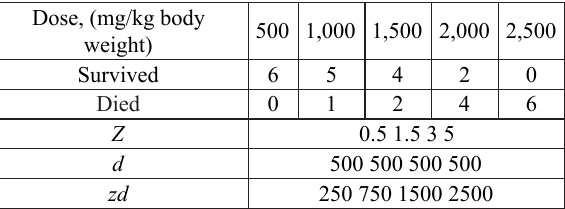
Mean lethal doses of the compound in white rats by intramuscular injection ( n =6)